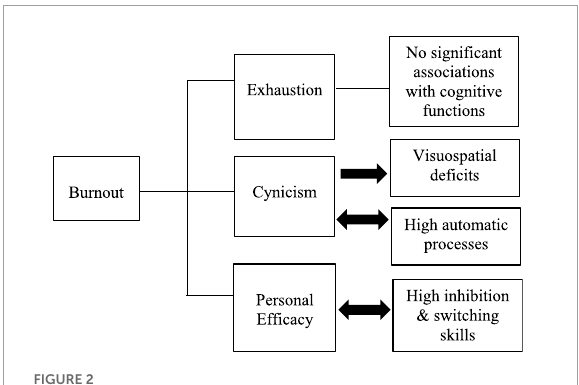
FIGURE2 Schematic figure of the results regarding the burnout—cognitive functioning relationship.